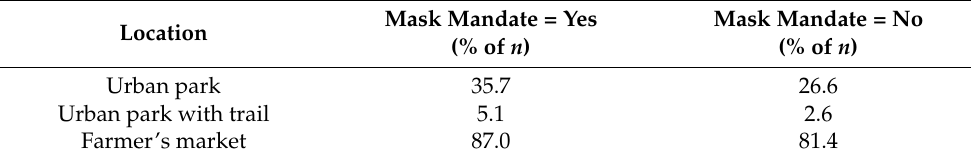
Table 2. Mask wearing behavior by statewide policy: Mask mandate vs. no mask mandate.